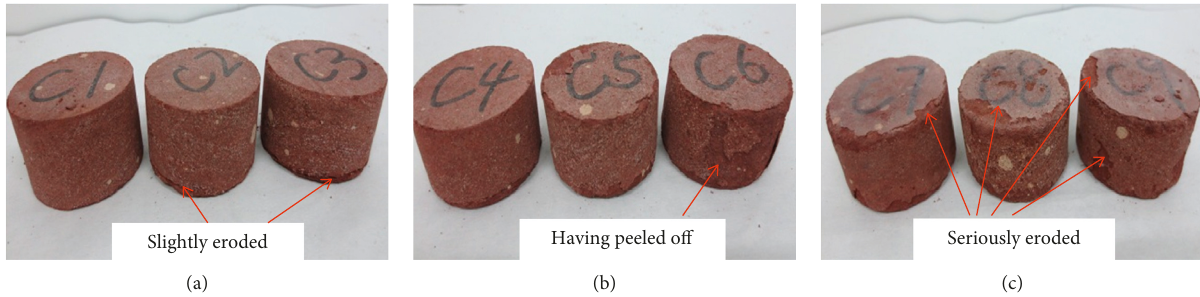
2 SO 4 solution: (a) 10 cycles; (b) 20 cycles;